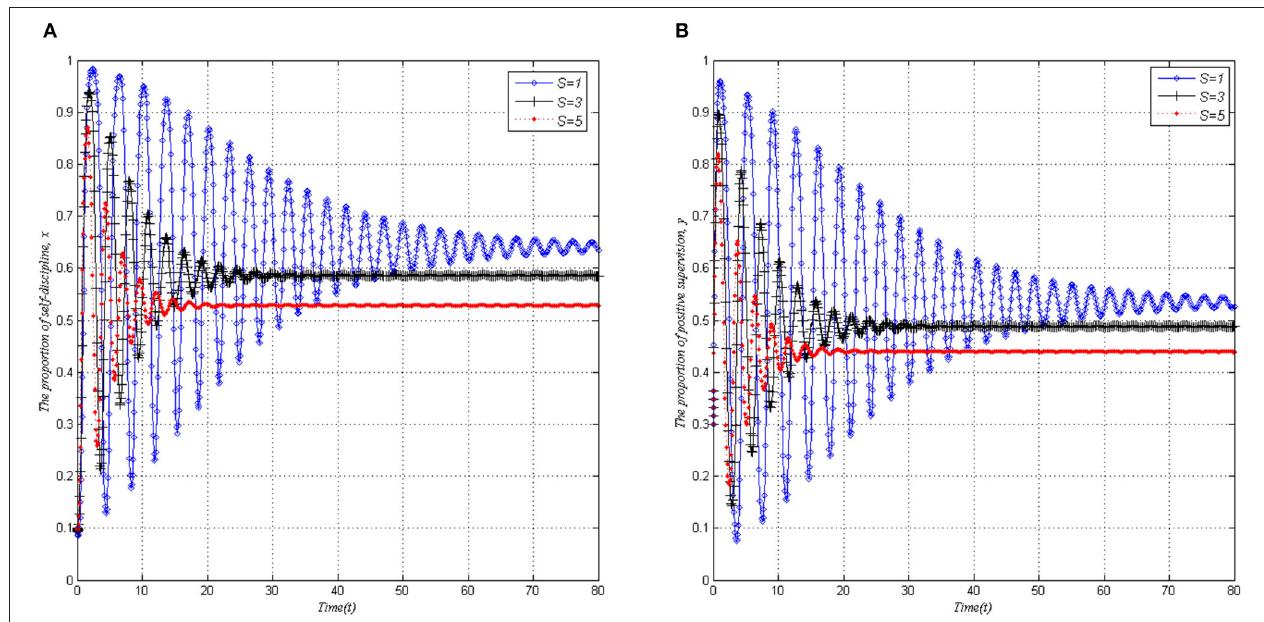
FIGURE 5 | Evolutionary stability of dynamic mechanisms ( P